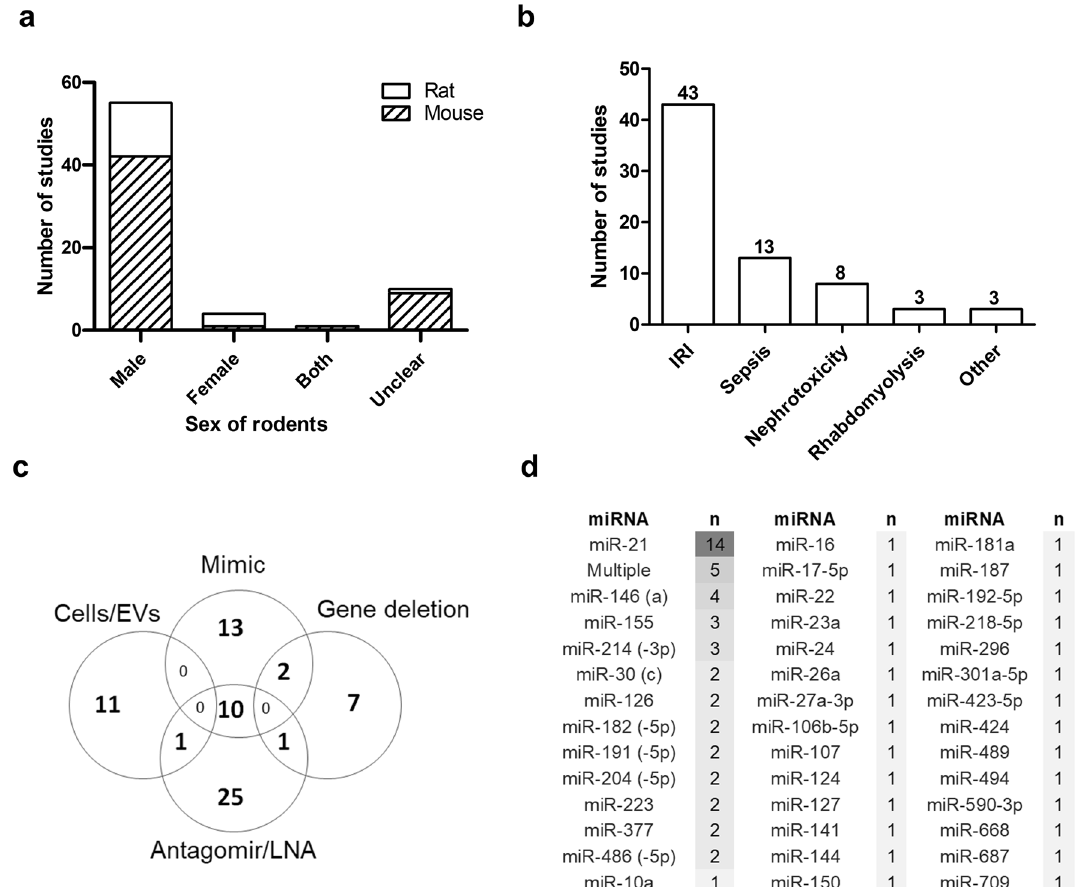
Figure 2. Study characteristics. Distribution of studies by ( a ) species and sex of rodents, ( b ) AKI model (IRI, ischemia–reperfusion injury), ( c ) Types of interventions used in the included studies (EV, extracellular vesicle; LNA, locked nucleic acid), and ( d ) Number of studies (n) per miRNA; further definition of miRNAs provided in some studies is designated in